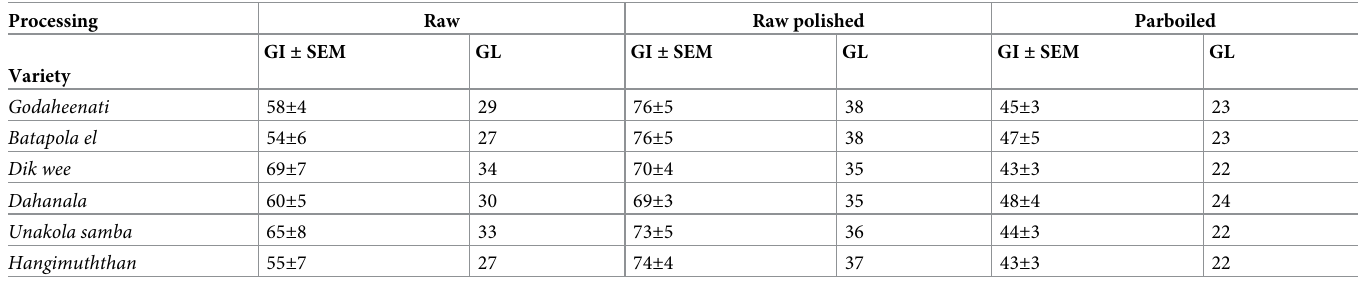
Table 4. Glycaemic indices (mean ± SEM) and glycaemic loads of differently processed rice. Processing Raw Raw polished